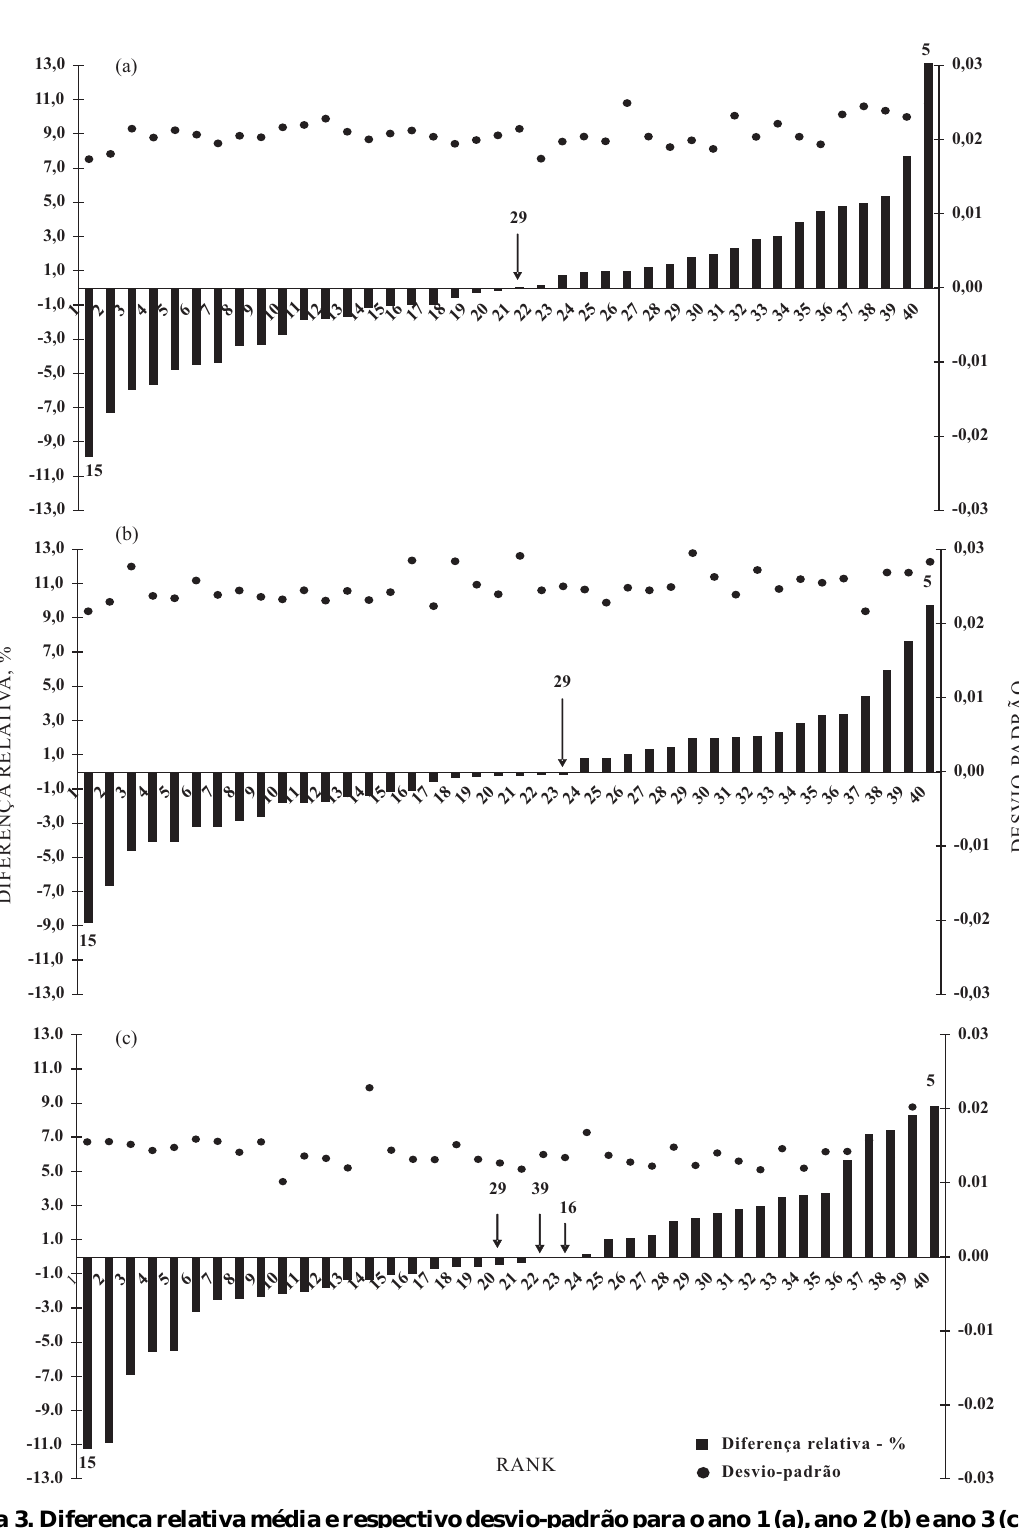
Figura 3. Diferença relativa média e respectivo desvio-padrão para o ano 1 (a), ano 2 (b) e ano 3 (c) com base na armazenagem de água no solo, listada do menor para o maior valor. Os números referem-se aos locais de